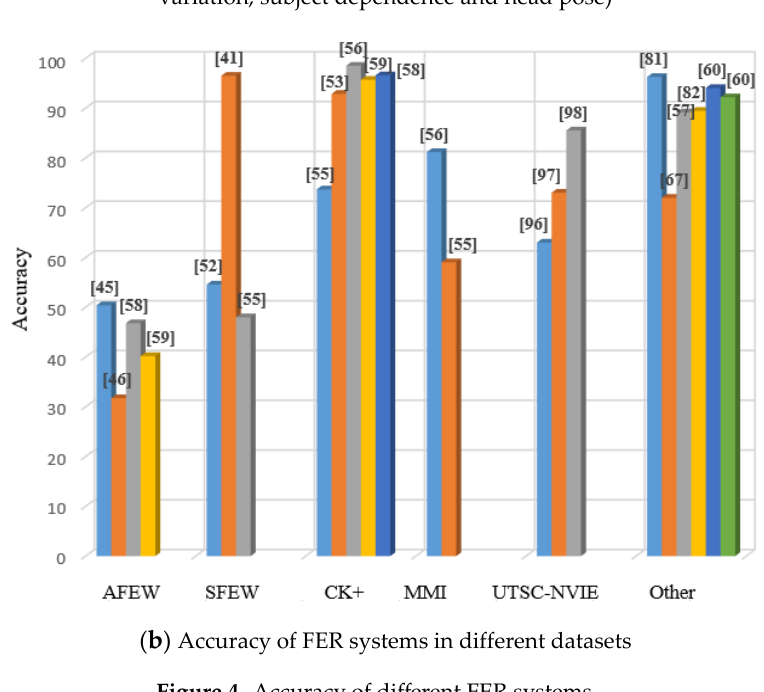
Figure 4. Accuracy of different FER systems.